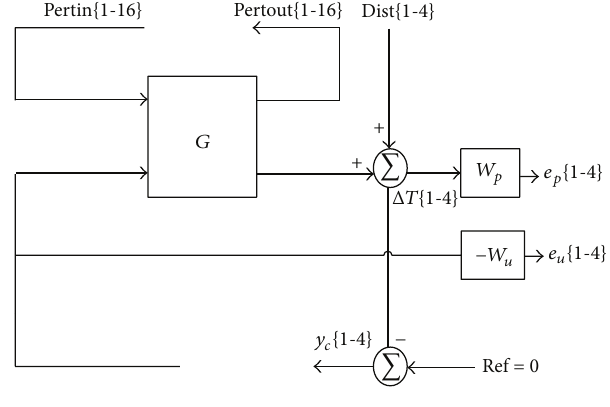
Figure 9: Structure of the open loop system.